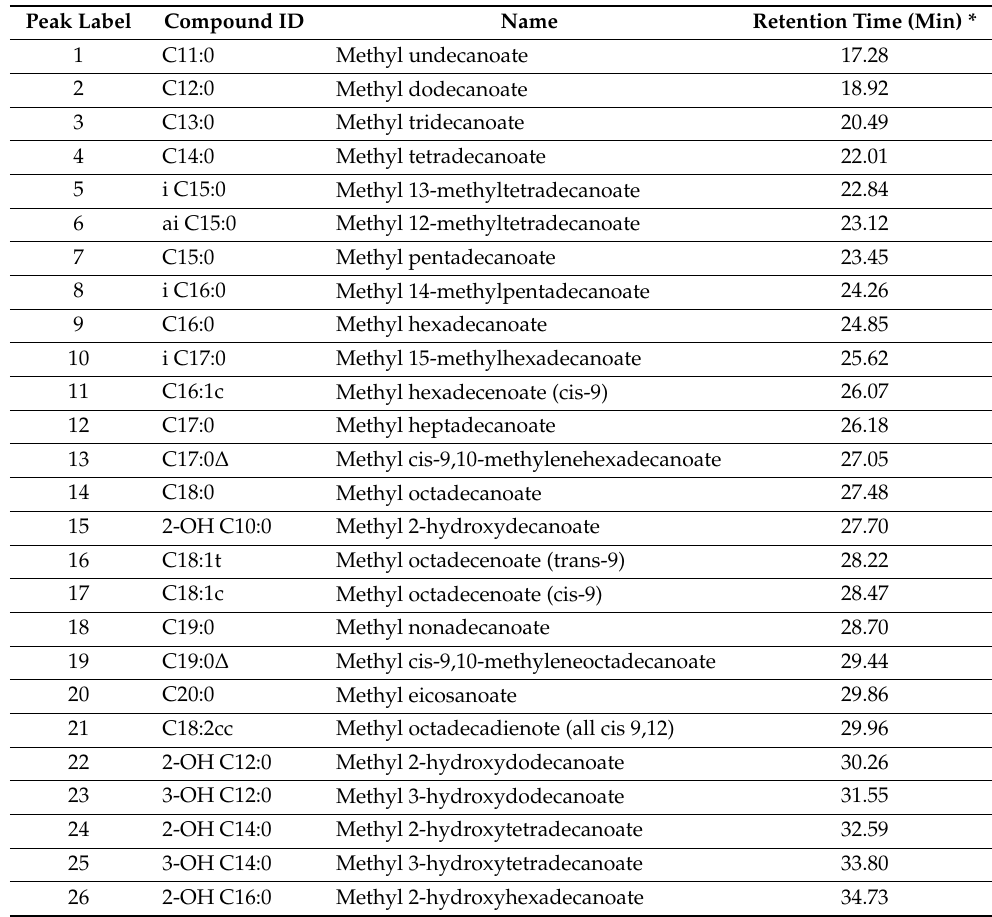
Table 1. Fatty acid methyl ester components of the BAME CP Mixture and their retention time values analyzed with GC-MS on an SLB-IL111 type 60 m long ionic liquid based separation column. The experimental conditions of the optimized method are given in the Section